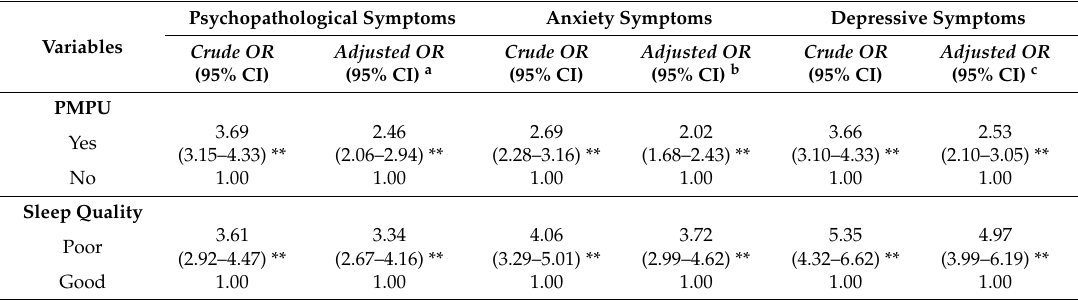
Table 2. Relationship of problematic mobile phone use (PMPU) and sleep quality with mental health.